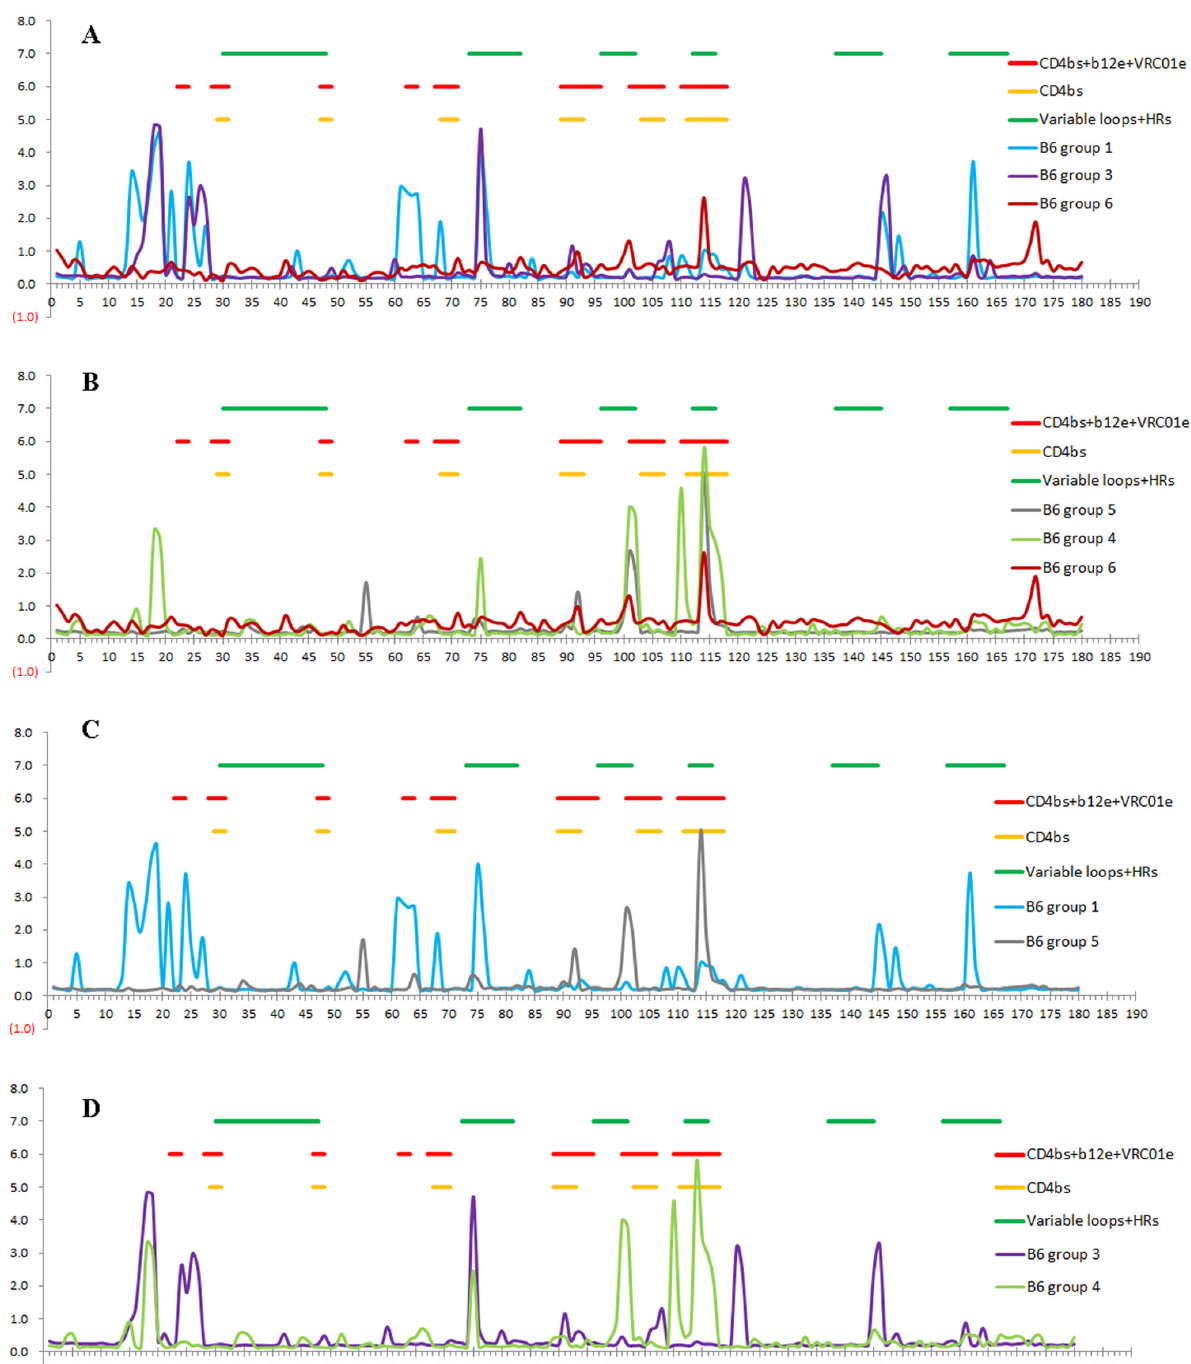
Fig 4. Comparison of profiles of different bleed 6 rabbit IgGs with consensus clade B 15-mer peptides. A-B: Profiles of rabbit IgGs from the immunization with or without (poly)peptide priming are compared. The profile of rabbit IgGs from immunization with P1-4 alone is included as a control. C: Profiles of rabbit IgGs from immunization with the same priming, but different order of the boosting immunogens are compared. D: Profiles of rabbit IgGs from two control groups without (poly)peptide priming and with different order of the boosting immunogens are compared. Locations of CD4bs peptides, b12 epitope (b12e) and VRC01 epitope (VRC01e), as well as Env variable loops and HR regions (HR1 and HR2) are indicated according to “ Neutralizing Antibody Resources ” (http://www.hiv.lanl.gov/content/immunology/neutralizing_ab_resources.html). Two serum samples from a same group were profiled separately, but the addition results of the two samples from the same group are shown. X axis: position of the peptides. Y axis: OD450nm.